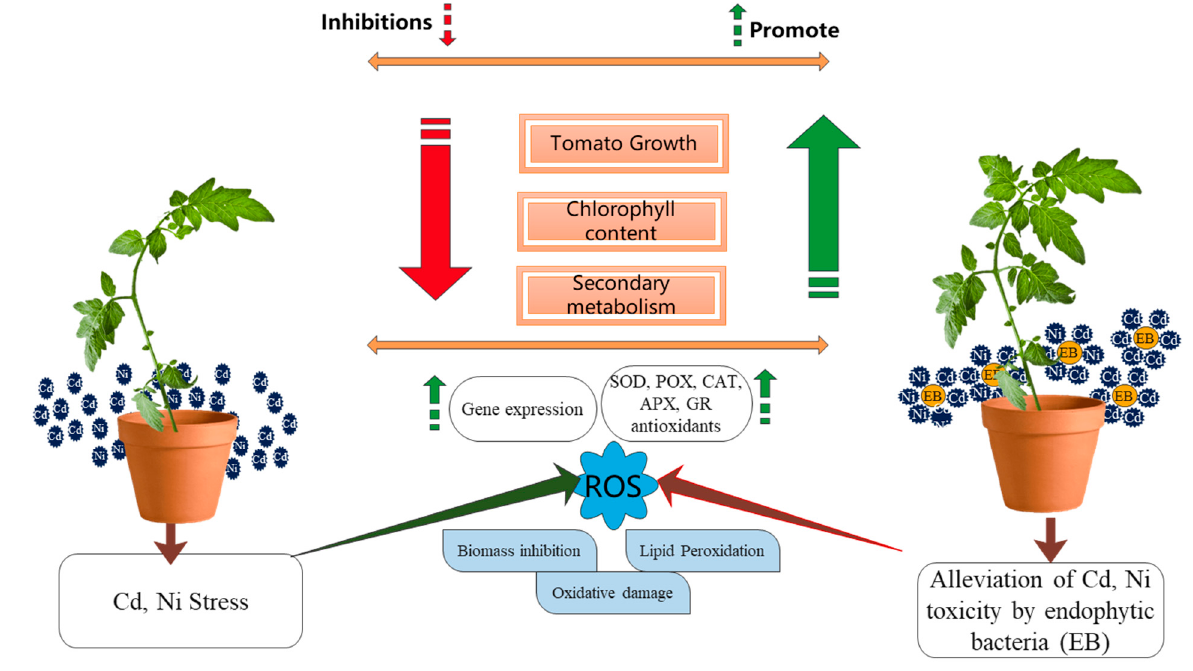
Figure 11. Mechanism of endophytic bacteria to promote plant growth and metabolites.